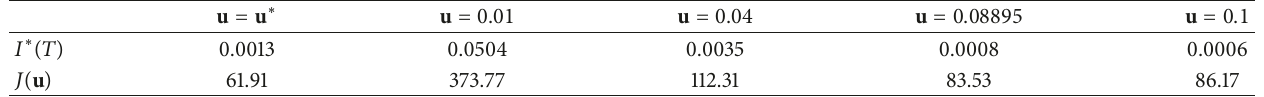
Table 3: 𝐼 ∗ (𝑇) and 𝐽 under different control strategies with 𝑚 1 = 𝑚 2 = 2 for Example 3. u = u ∗ u =